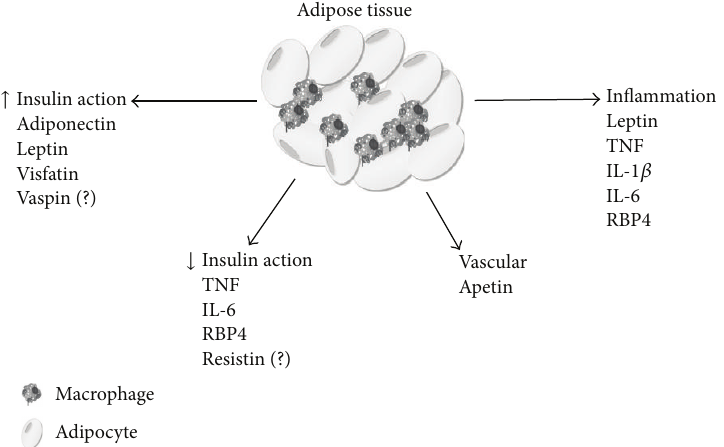
Figure 1: The adipose tissue secretes molecules called adipokines. These adipokines act locally (adipose tissue) and systemically, regulating several aspects of body homeostasis, including the immune system, the cardiovascular system, and insulin